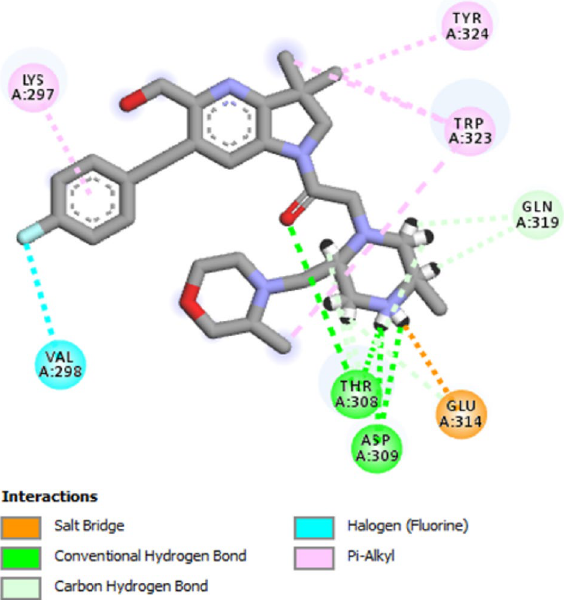
Figure 4. Depicted figure showing the binding site of the protein with the selected ligand complex (PDB ID: 5OQW). Several types or interaction were shown by color with different amino acids residues.